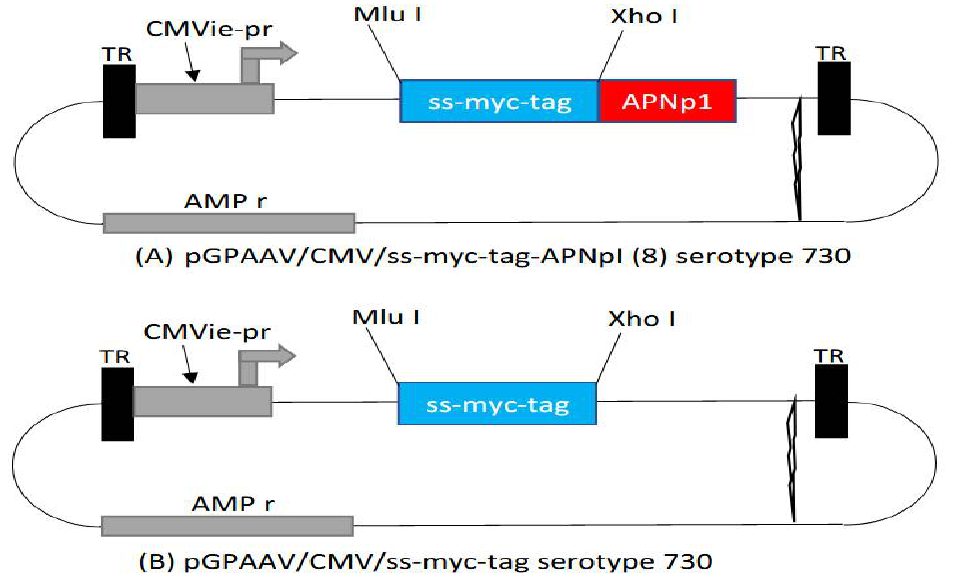
Figure 5. (A ) pGPAAV/CMV/ss-myc-tag-APNpI (8) serotype 730; ( B ) pGPAAV/CMV/ss-myc-tag serotype 730. The top figure ( A ) is AAV with APNp1 inserted in it (Red) and the bottom figure ( B ) shows normal AAV with no APNp1 inserted in it, used as a